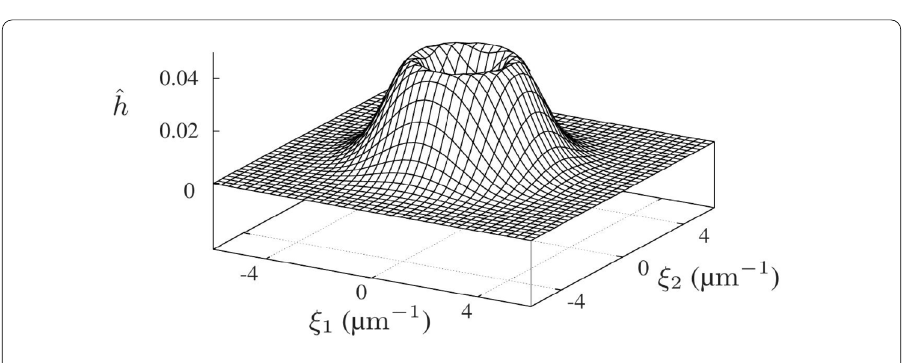
μ m and σ 2 = 1 μ 2